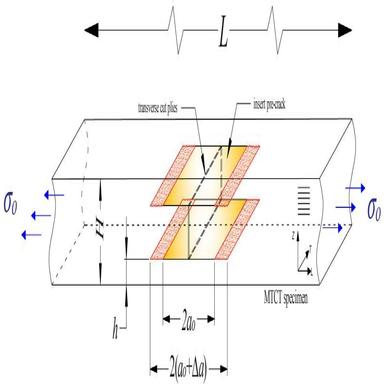
Sketch of a Modified TCT specimen.